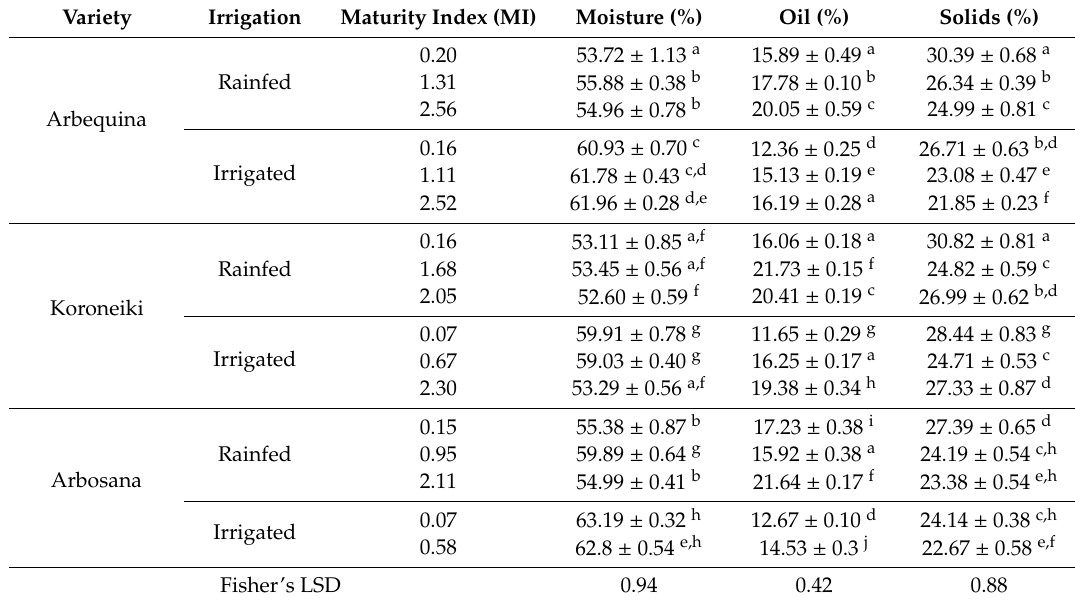
Table 1. Compositional characteristics and maturity index of the processed olives